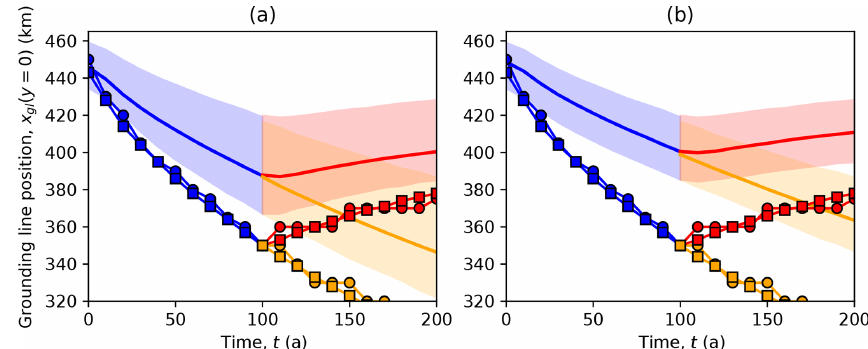
Figure 8. Ice1 midchannel grounding line position plotted against time for the PSU HySSA models compared to other models. The HySSA models (solid lines with symbols) both exhibit a retreat rate around twice as fast as the main subset mean (shaded regions, panel a ), and 3 times as fast as the Weertman subset mean (shaded regions, panel b